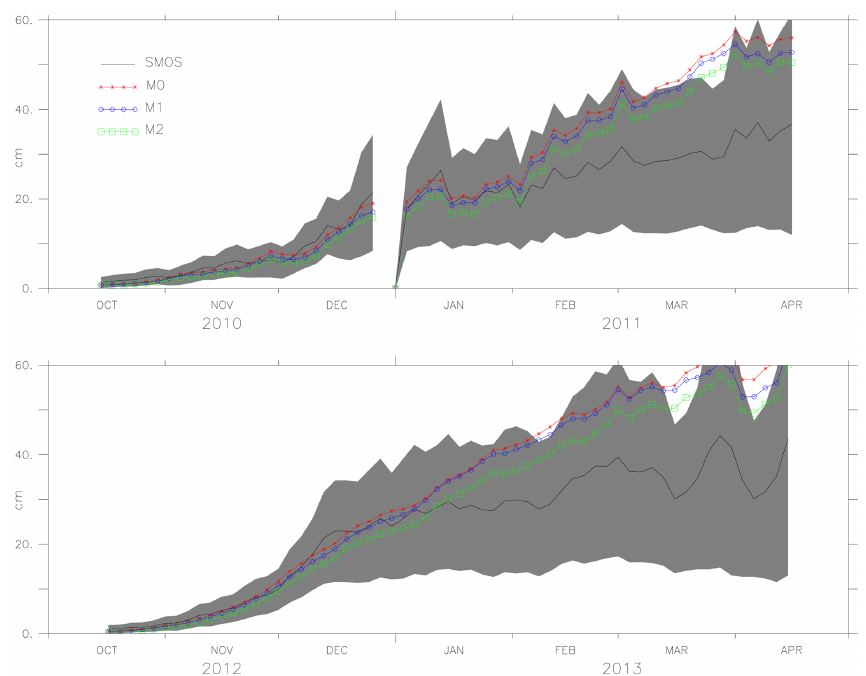
Figure 6. The ice thickness from the models M0, M1, M2 and observation (SMOS ice thickness) from October 2010 to April 2011 and October 2012 to April 2013. The uncertainty in the observation (SMOS ice thickness) is shaded in grey.